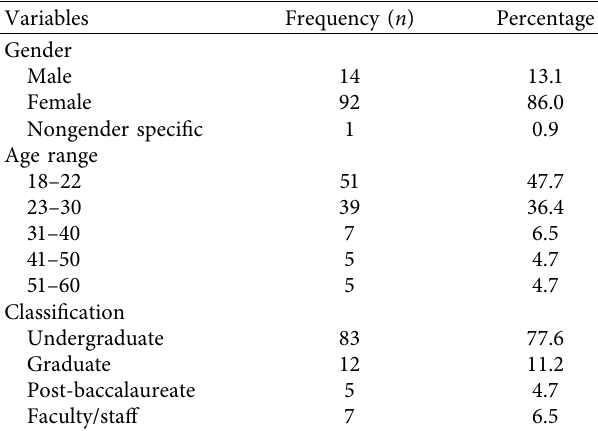
Table 3: Demographic characteristics of consumer test